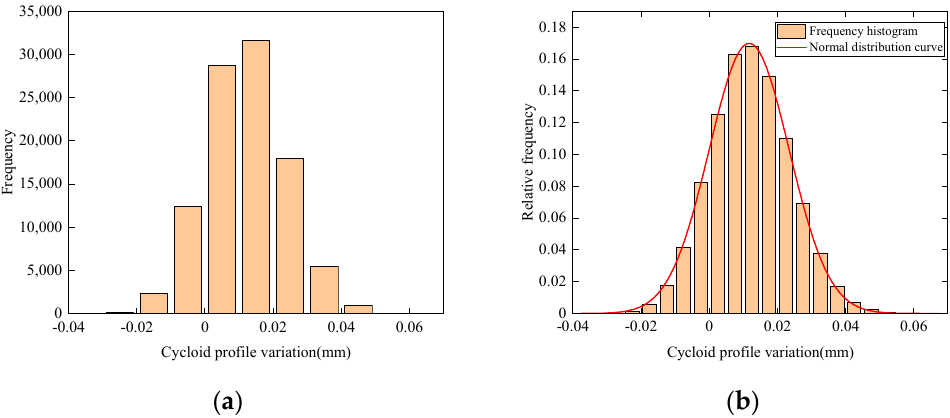
Figure 10. Simulation results of tooth profile variation: ( a ) statistics of tooth profile variation; ( b ) normal fitting of tooth profile variation.